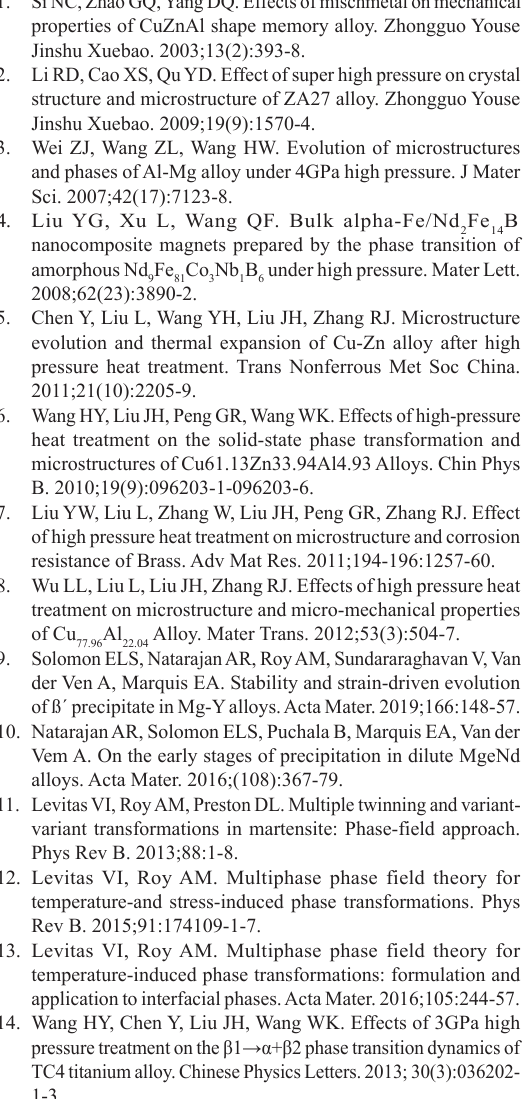
energy of the α+γ →ß solid phase transformation 2 and elevate Avrami exponent during heating process, but it has less effect on the mechanism of the solid phase transformation.